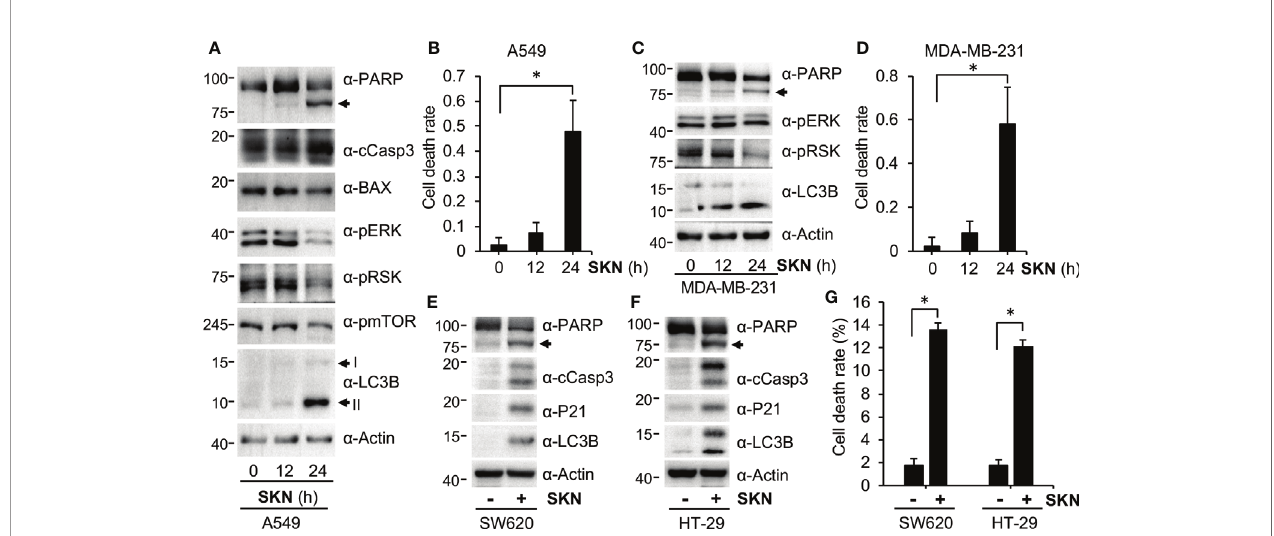
FIGURE 4 | Shikonin induces cell death. (A) PANC-1 cells were treated with 5 m M of Shikonin for 0, 12 and 24 h, and protein expression was measured using speci fi c antibodies. I and II indicate non-modi fi ed and lipidated forms of LC3B, respectively. Anti-PARP recognizes both full-length and cleaved PARP proteins, and the latter is indicated by the arrow. (B) Quantitation of dead cell population from cells in (A) by trypan blue staining. Data represent mean and standard deviation from fi ve replicates. *P <0.001. (C) MDA-MD-231 cells were treated with 5 m M of Shikonin for 0, 12 and 24 h, and protein expression was measured by speci fi c antibodies. (D) Quantitation of dead cell population from C by trypan blue staining. Data represent mean and standard deviation from fi ve replicates. *P <0.001. SW620 (E) or HT-29 (F) cancer cells were treated with 5 m M of Shikonin for 12 h, and protein expression was measured by speci fi c antibodies. (G) Quantitation of dead cell population from E and F by trypan blue staining. Data represent mean and standard deviation from fi ve replicates. *P <